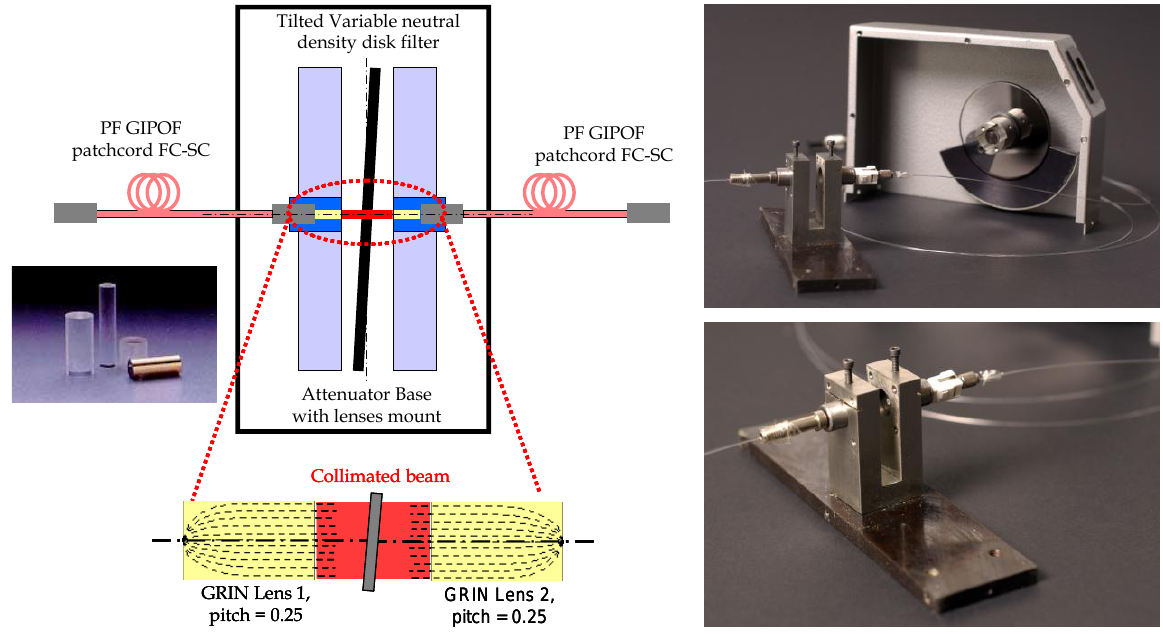
Figure 14. Description of the designed